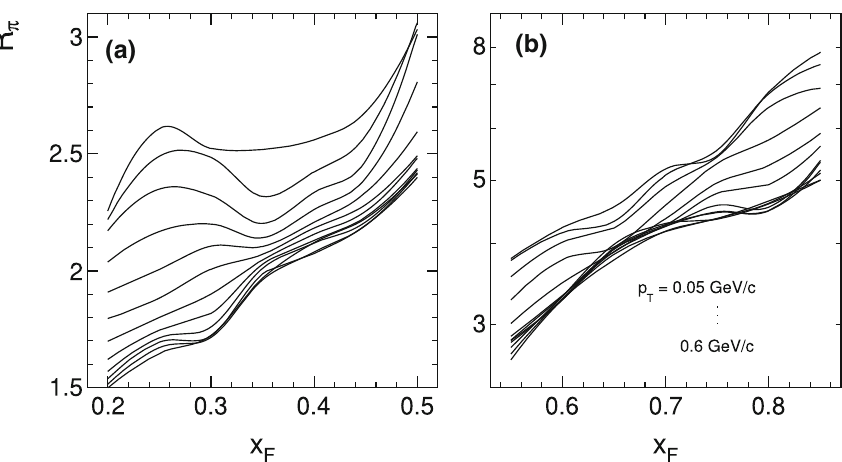
Fig. 89 R π ratio as a function of x F for p T between 0.05 and 0.6 GeV/c. Panel a x F from 0.2 to 0.5 in linear scale, panel b x F from 0.5 to 0.85 in logarithmic scale